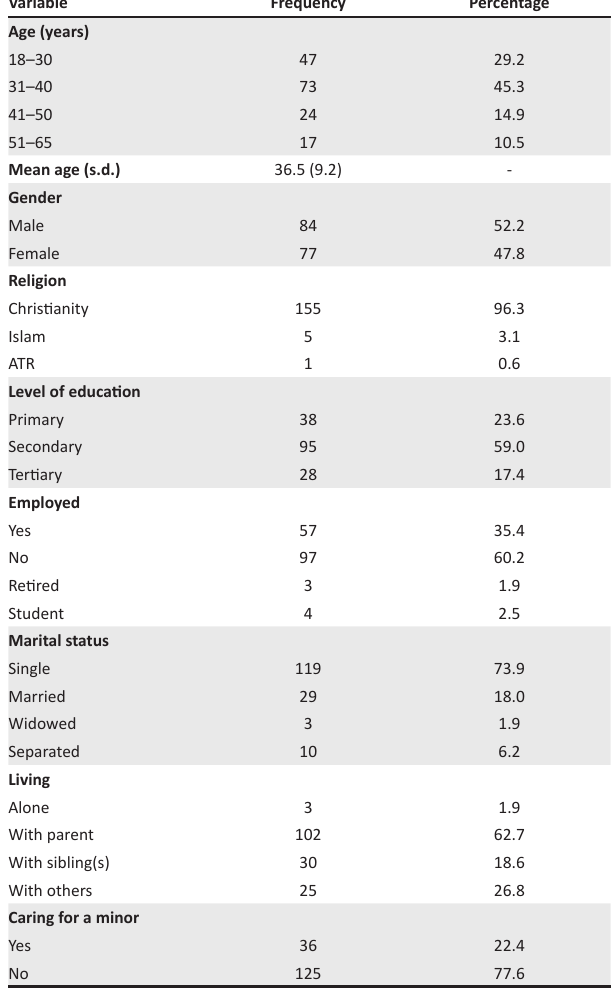
TABLE 1: Socio-demographic characteristics of patients.